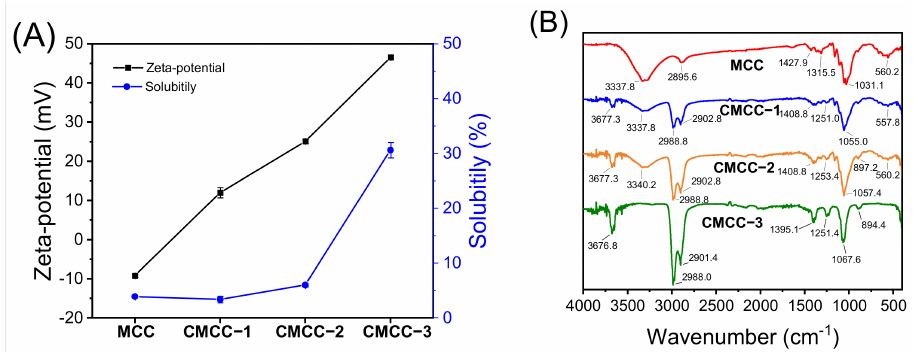
Figure 1. ( A ) The zeta-potential and water-solubility and ( B ) FTIR measurement of MCC and CMCC. The Fourier transform infrared (FTIR) spectra of MCC and CMCC are shown in Figure 1B. The absorption peak around 3337 cm − 1 usually represents the stretching of hydroxyl group and hydrogen bond interaction [26]. For MCC, the intensity of this